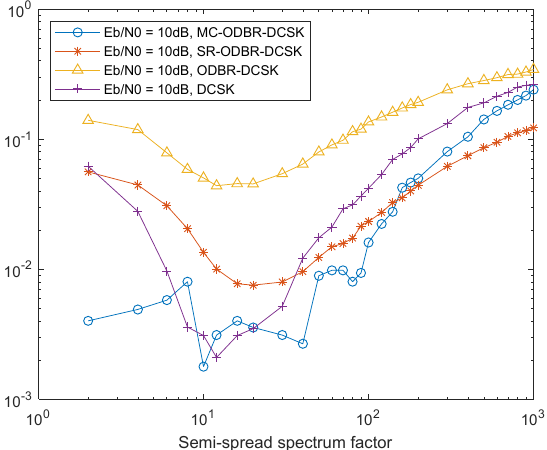
Figure 13. Relationship between semi − spread spectrum factor and bit error rate in Gaussian chan-